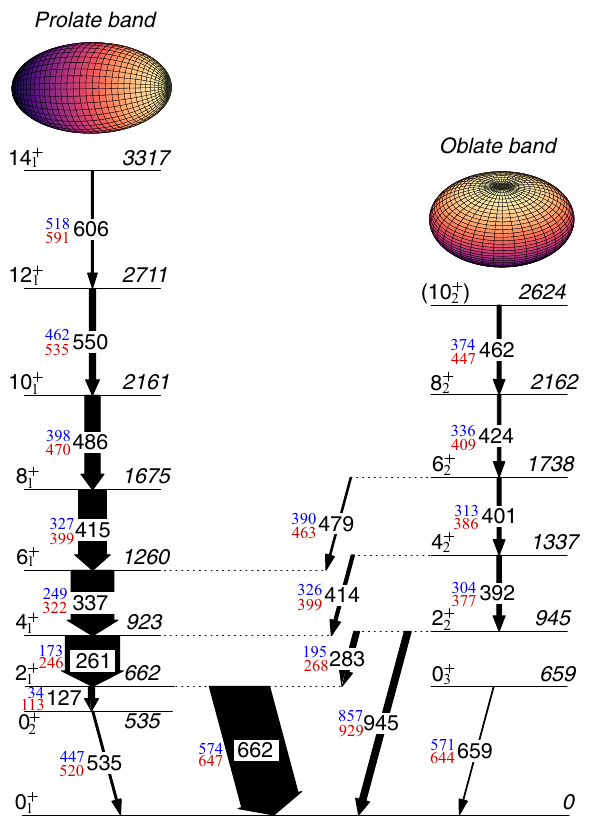
Fig. 3 Partial level scheme of 186 Pb presenting transitions relevant to the present work. The widths of the arrows are proportional to the total transition intensities. The K- and L-conversion electron energies have been labelled in blue and red, respectively.